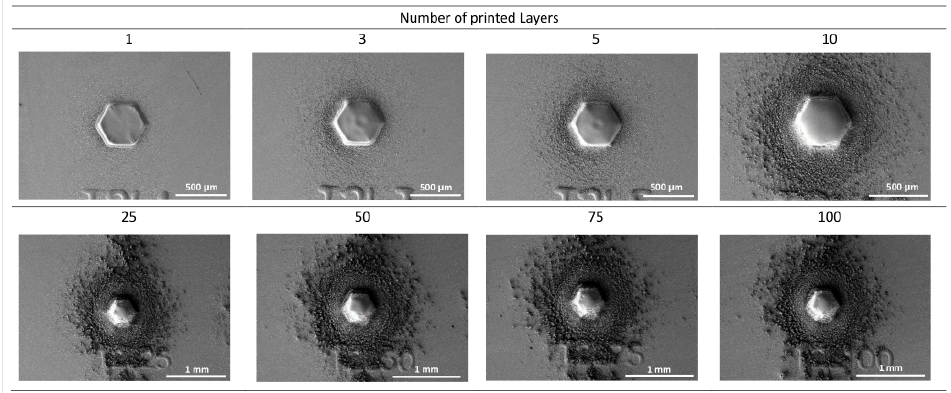
Figure 6. Over-spray effect depending on the number of printed